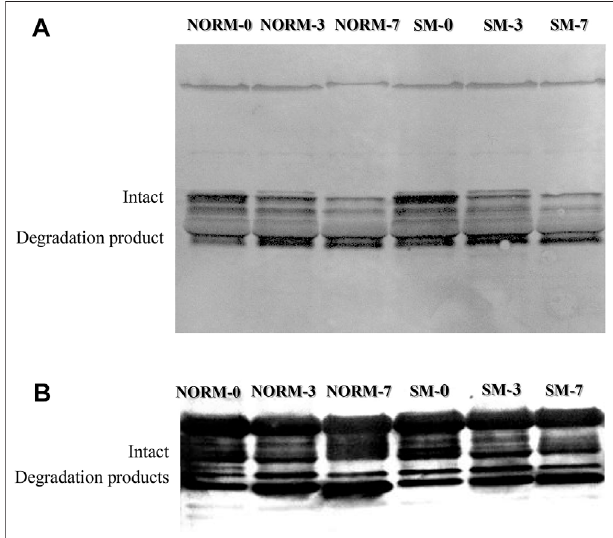
FIGURE 5 | Representative western blot for desmin (A) and troponin-T (B) according to muscle condition (normal, NORM; Spaghetti Meat, SM) and postmortem time (0, 3, 7 days).